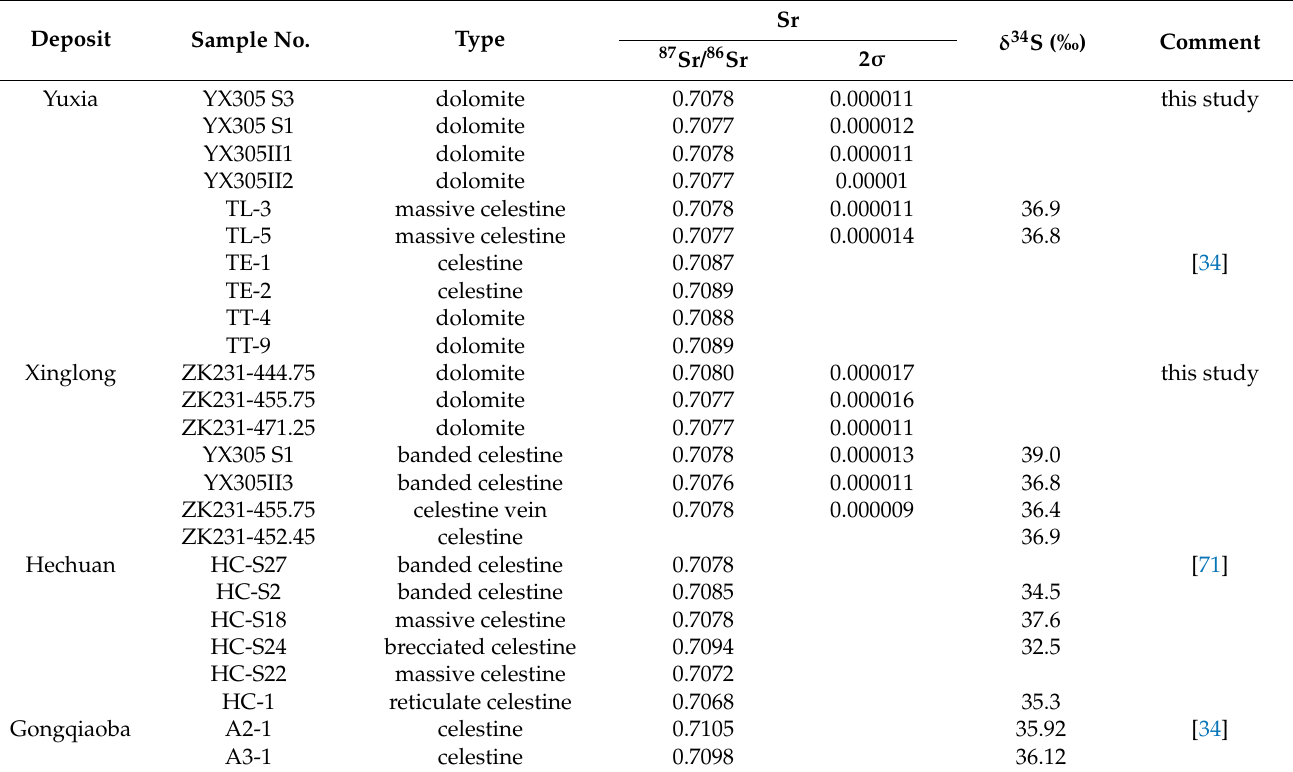
Table 3. Sulfur isotopic and strontium isotope composition of celestine and country rocks from the Huayingshan area.